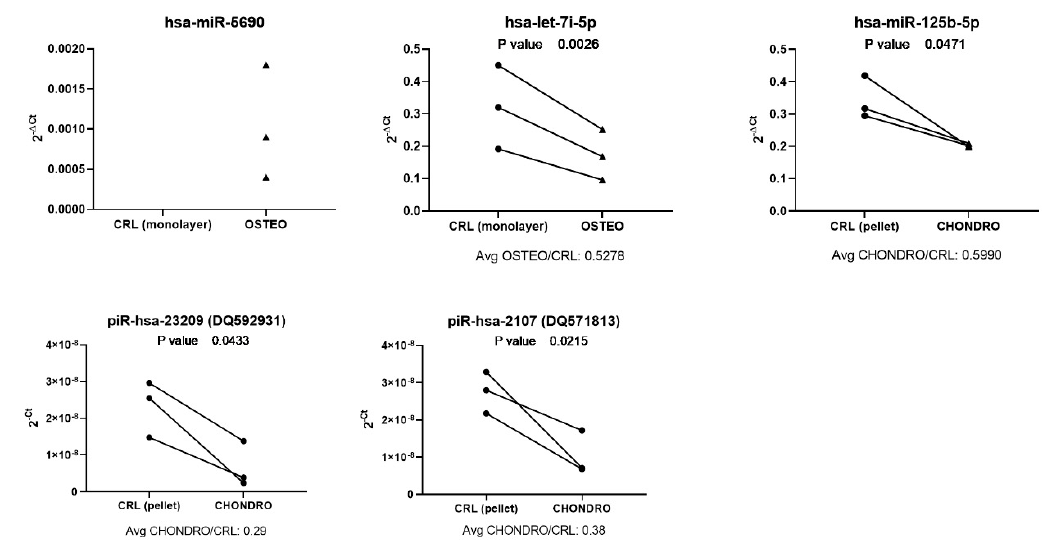
Figure 5. qPCR validation of miRNA and piRNA expression in early osteogenic or chondrogenic differentiation.